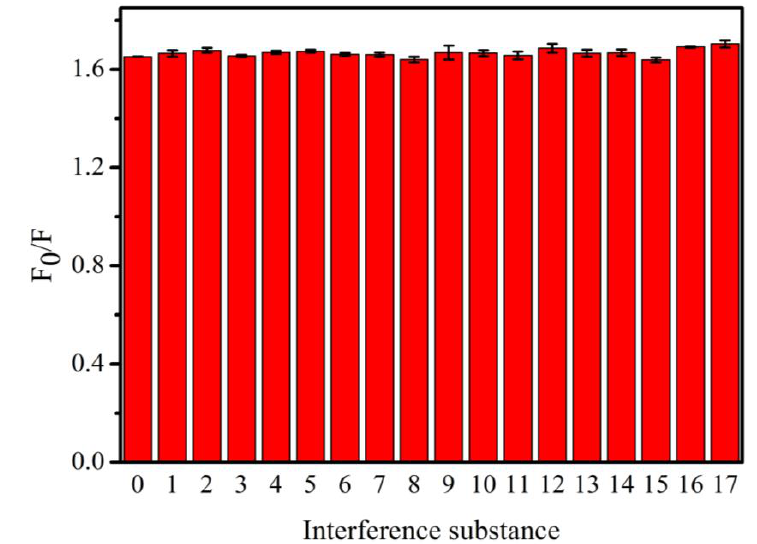
Figure 9. Effects of potentially interfering substances: (0) non-interference; (1) K + , 25 mM; (2) Na + , 25 mM; (3) Mg 2+ , 25 mM; (4) NH + , 25 mM; (5) NO − , 25 mM; (6) SO 2− , 25 mM; (7) CO 2− , 25 mM; (8) glucose, 25 mM; (9) lactose, 25 mM; (10) starch, 25 mM; (11) oxalic acid, 25 mM; (12) glycine, 25 mM; (13) L -histidine, 25 mM; (14) ascorbic acid, 6.25 mM; (15) β-cyclodextrine, 6.25 mM; (16) ronidazole, 625 μM; (17) secnidazole, 625 μM. Conditions: FCNs, 500 μL; PBS, 0.2 M, pH 7.0; MNZ, 125.00 μΜ.